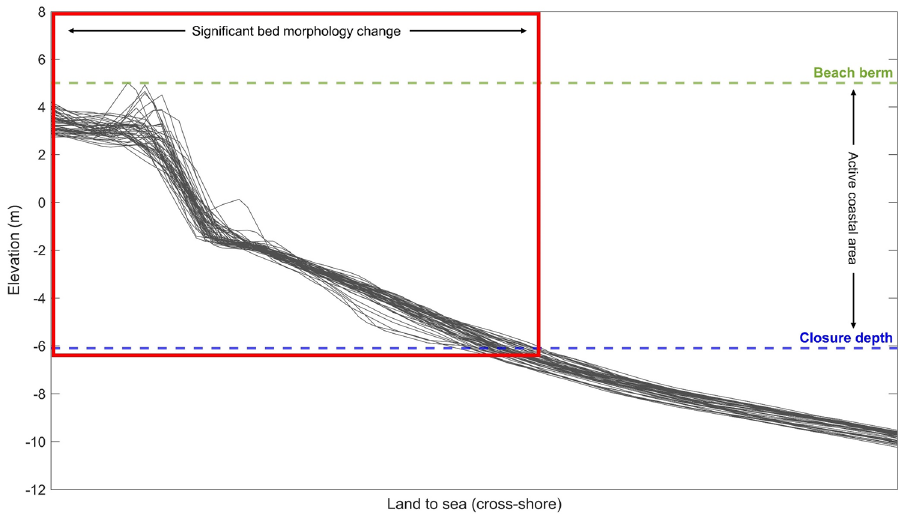
Figure 4. Schematic illustration on identifying the closure depth along a coastal profile. The closure depth is traditionally considered to be the depth beyond which we can see no significant changes in bottom elevation (bed morphology). This typically coincides with the basal limit of the envelope of coastal profile changes.